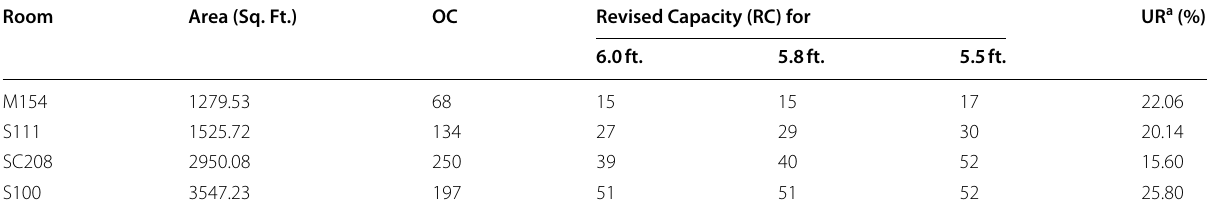
Table 1 Results for fixed-seating classrooms with different social distances